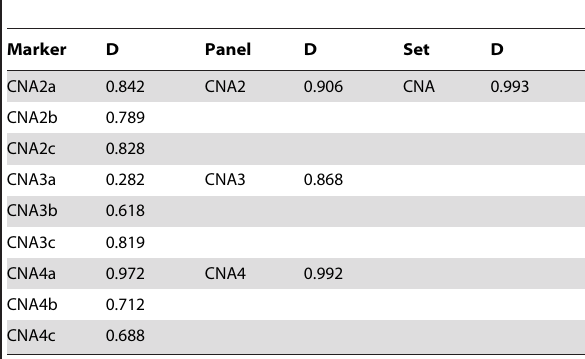
Table 2. Overview of the discriminatory power of the individual markers, panels of markers and the entire set of markers. Calculated values are based on the Simpson’s index of diversity and are expressed in a value of ‘D’